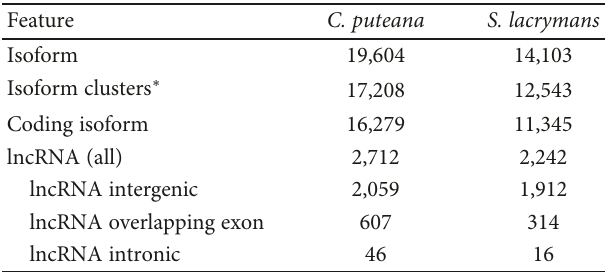
Table 1: Classi fi cation of assembled transcripts in C. puteana and S.